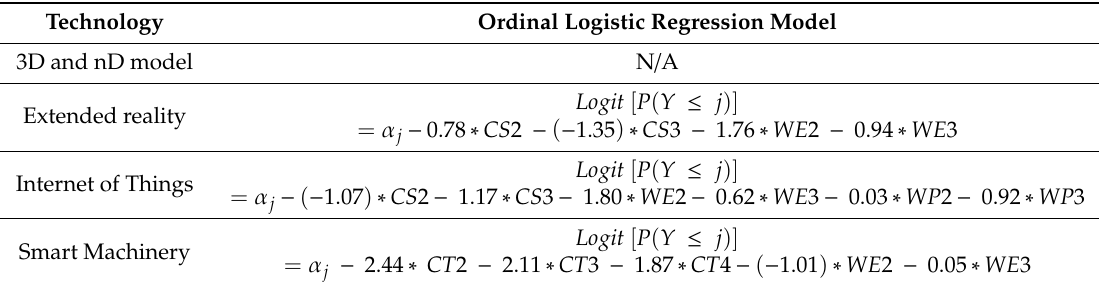
Table 3. Ordinal logistic regression model for the United States.